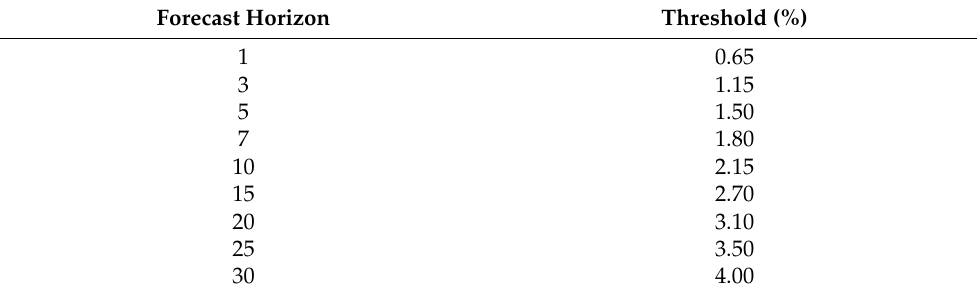
Table 1. Horizon with